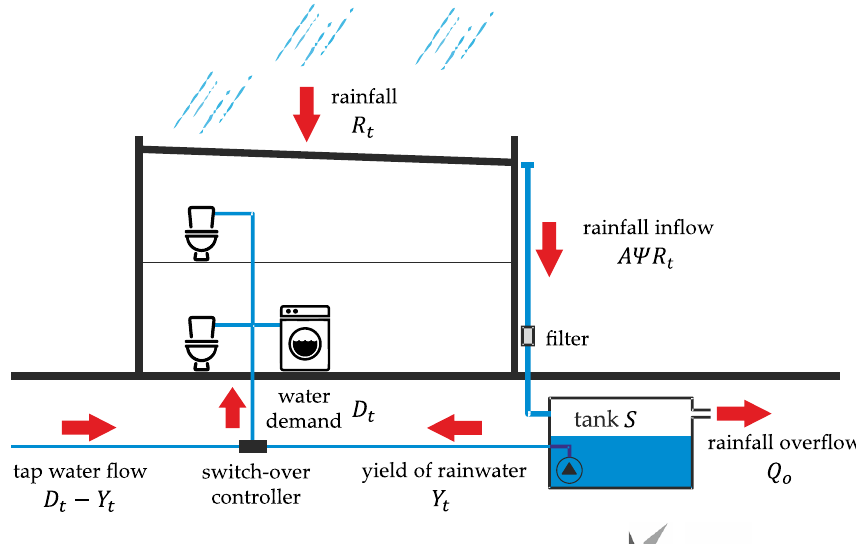
Fig. 1 The diagram of the water balance model for rainwater harvesting